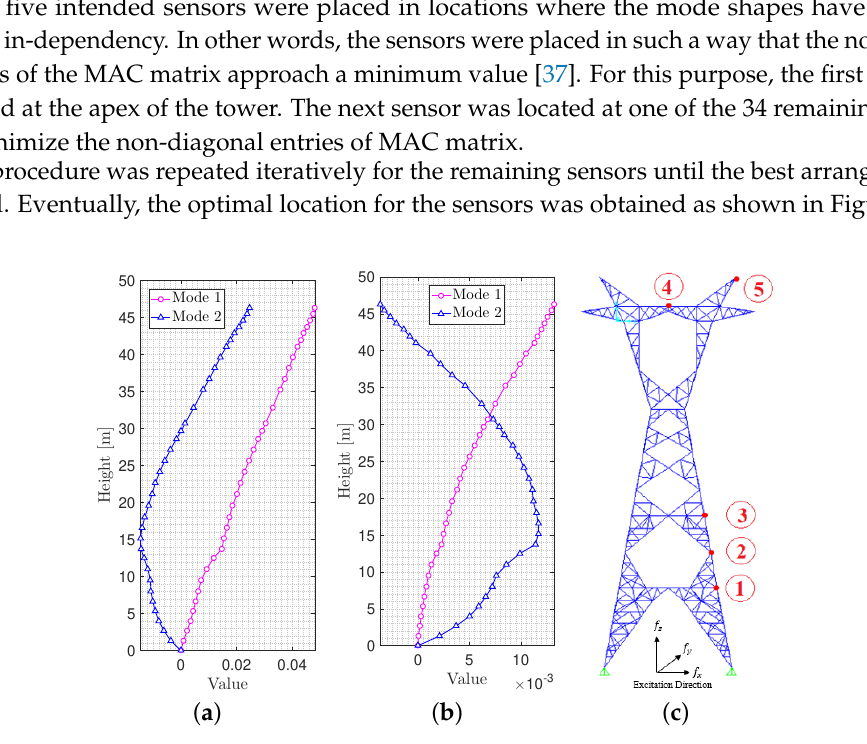
Figure 8. Mode shapes of the tower in 35 nodes along the height and optimal locations. ( a ) 1st and 2nd mode shapes; latitudinal direction; ( b ) 1st and 2nd mode shapes; longitudinal direction; ( c ) Optimal sensor